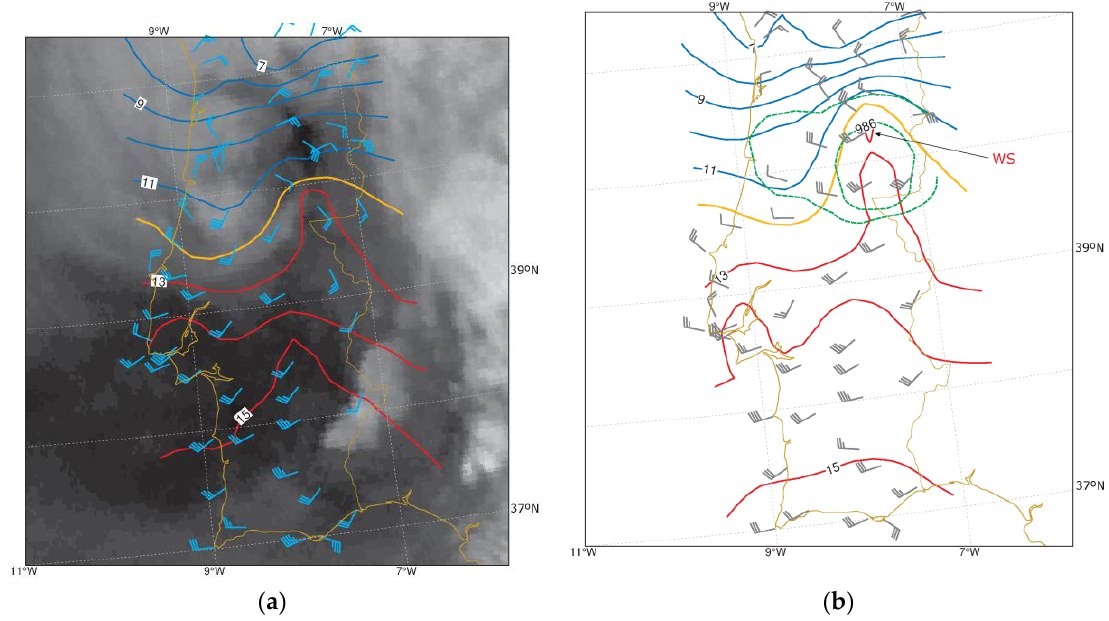
Figure 16 . ( a ) MSG WV6.2 image superimposed with observations of surface θ w (1 °C intervals, from 7 to 11 °C in the blue lines, 12 °C in orange lines and ≥13 °C in red lines) and wind gust at 10 m (blue barbs) at 05:40 UTC; ( b ) Surface θ w (1 °C intervals, from 7 to 11 °C in blue lines, 12 °C in orange lines and ≥13 °C in red lines), MSLP (986 and 987 hPa isobars, in green dashed lines) and wind gust at 10 m (grey barbs) at 07:40 UTC. The warm seclusion (WS) is indicated in (b).